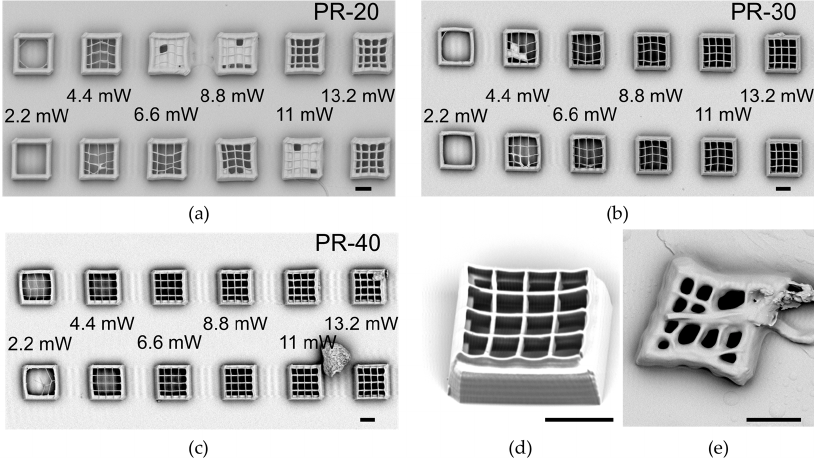
Figure 3. Writing tests for the rigidity and rod dimensions at varying laser powers and writing speeds (90 µm/s for the first row and 60 µm/s for the second row). In the SEM images are shown: ( a ) PR-20 ; ( b ) PR-30 ; ( c ) PR-40 ; ( d ) A grid of PR-40 realized with a writing speed of 90 µm/s and a laser power of 12.9 mW; ( e ) A grid realized with PR-10 , a writing speed of 90 µm/s, and a laser power of 12.9 mW. The scale bar is 10 µ m.